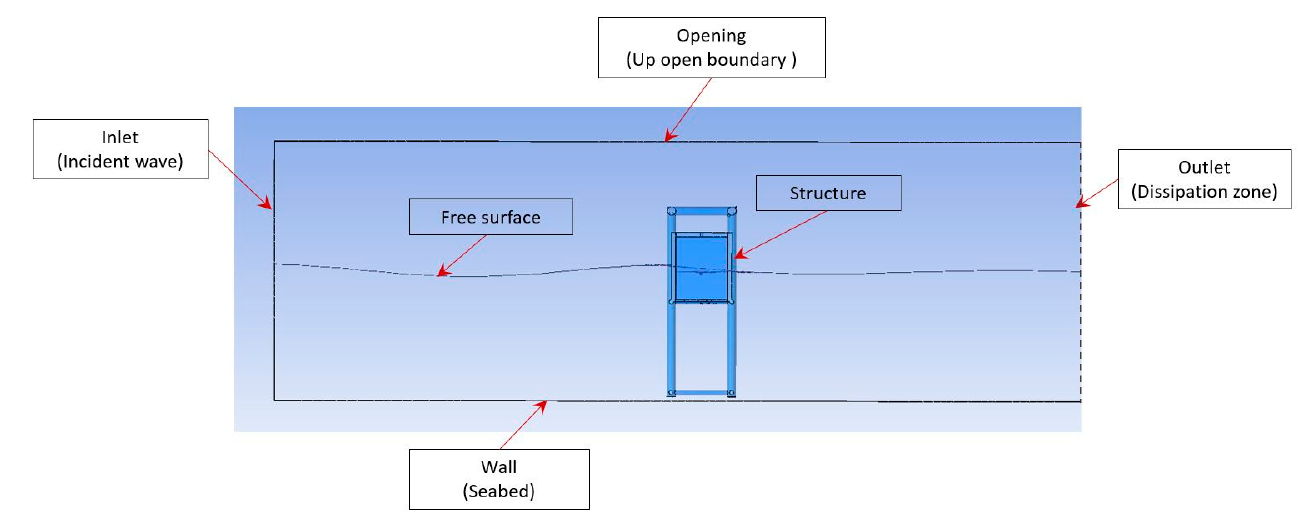
Figure 3. Schematic drawing of the boundary conditions.